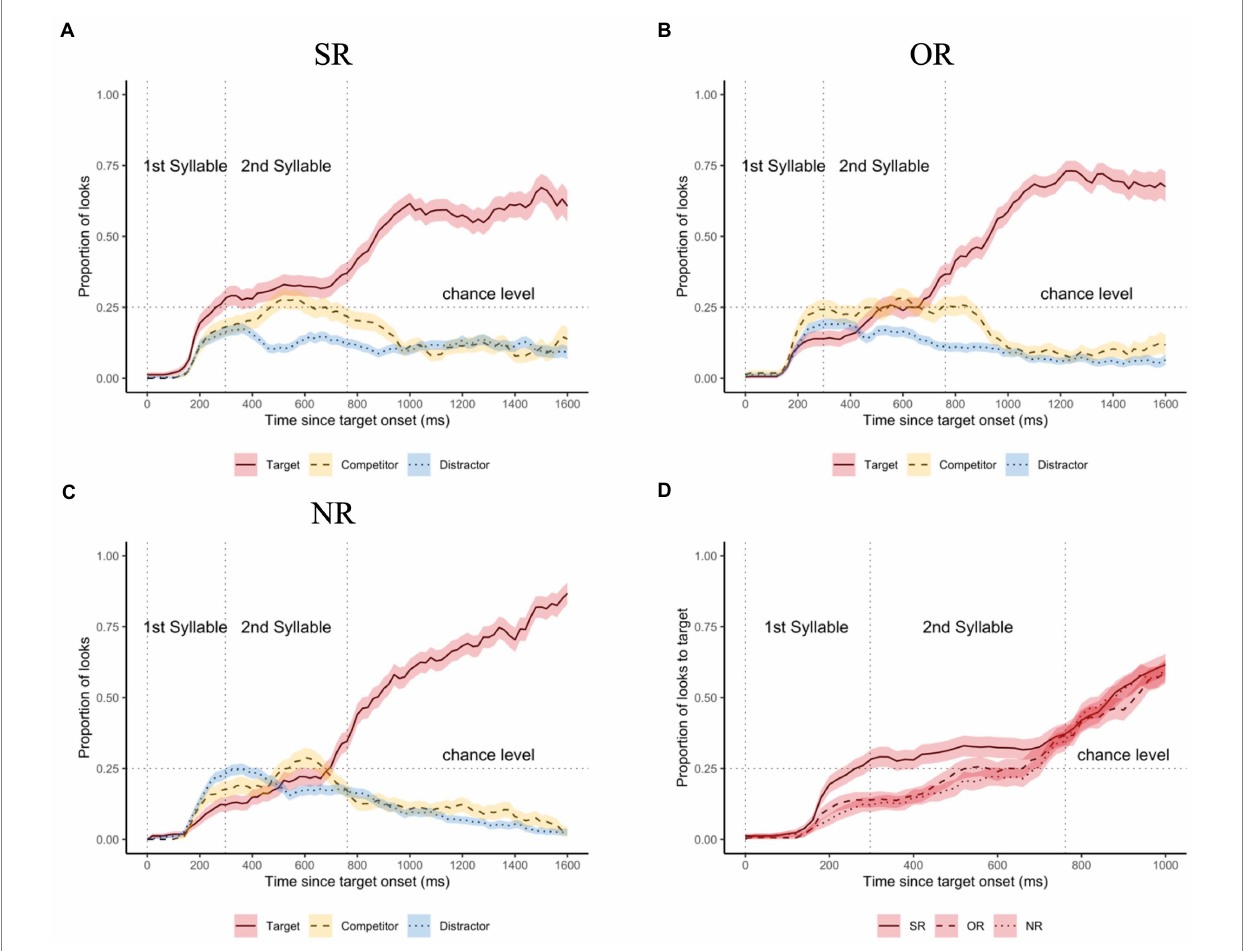
FIGURE 3 The mean proportion of looks in the three tonal coarticulation conditions. Panels (A) – (C) plot the proportions of looks to different visual objects until 1,600 ms since target onset in the SR condition (A) , the OR condition (B) , and the NR condition (C) , respectively. Solid lines indicate the mean proportions of looks to the targets (with red ribbons for the ±1 standard error); dashed lines for the mean proportions of looks to the competitors (with yellow ribbons for the ±1 standard error); dotted lines for the distractors (with blue ribbons for the ±1 standard error). Panel (D) plots proportion of looks to the target in the three conditions until 1,000 ms since target onset. Solid lines indicate the mean proportions of looks to target in the SR condition; dashed lines for the OR condition; dotted lines for the NR condition. Red ribbons for the ±1 standard error. Vertical lines indicate the mean syllable boundaries of the auditory stimuli, horizontal lines indicate the chance